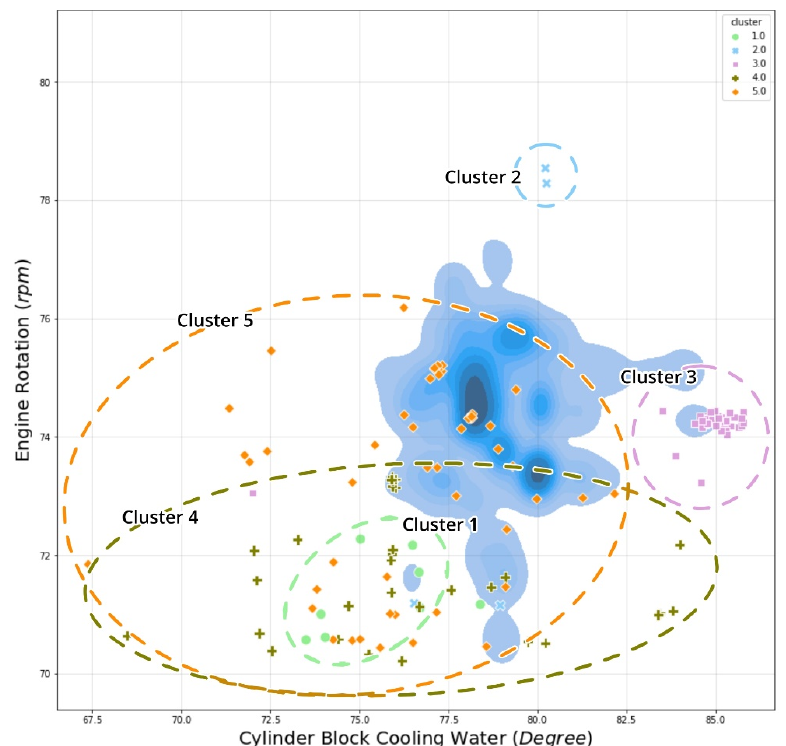
Sensors 2021 , 21 , 5200 Figure 16. Temperature of cylinder block cooling water vs. RPM cross plot with cluster distribution.